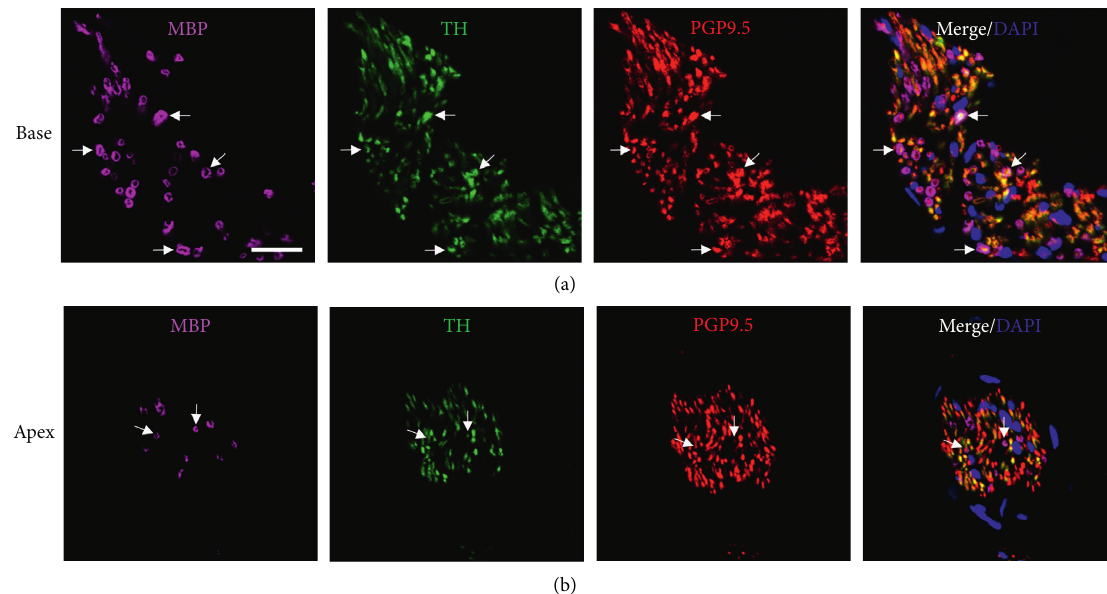
Figure 4: A subset of sympathetic axons in myocardial nerve bundles are myelinated. Photomicrographs of immunofluorescent labeling of MBP, TH, and PGP9.5 in myocardial nerve bundles in the base (a) and apex (b) levels of a control animal. Scale � 50 μ m. White arrows point to sympathetic axons (green TH-immunoreactivity (-ir) and red PGP9.5-ir; yellow color) that are myelinated (surrounded by pink MBP-ir). MBP, myelin basic protein; TH, tyrosine hydroxylase; PGP9.5, protein gene product